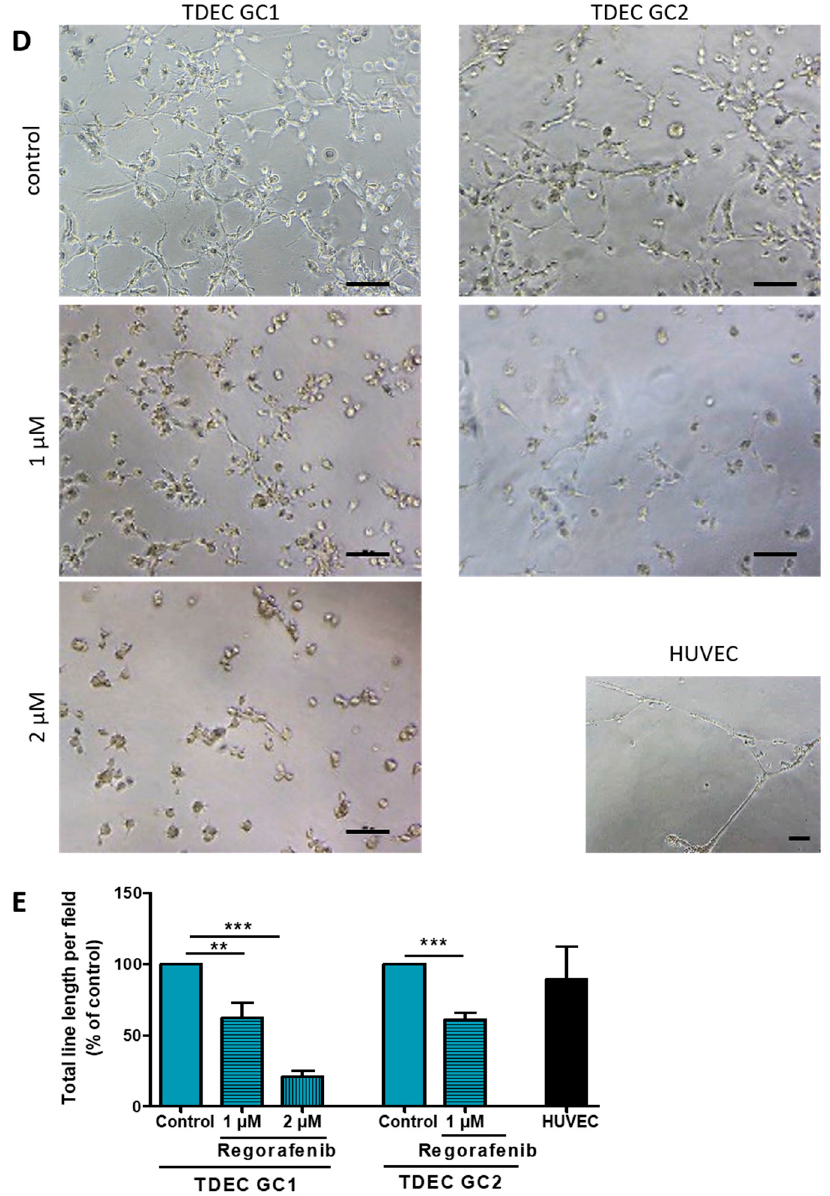
Figure 3. Regorafenib inhibits GSC transdifferentiation into TDEC in vitro. ( A ) GSC isolated from 2 patients (GC1 and GC2) were cultured in EGM-2 for 15 days in order to obtain TDEC (TDEC GC1 and TDEC GC2). ( B ) Immunoblot of CD31 in TDEC GC1 and TDEC GC2 with or without 1 or 2 µM of regorafenib. The graph shows the protein expression ratio normalised to TDEC obtained from each GSC and not treated with regorafenib (control). ( C ) Flow cytometric analysis of CD31 expression in TDEC obtained from GC1 and GC2 with or without regorafenib. The level of CD31 positive cells is expressed as the mean ± SEM normalised to TDEC obtained from each GSC and not treated with regorafenib (control). HUVEC is shown here as a positive control of CD31 expression. ( D , E ) Pseudotube formation assay. ( D ) Representative photographs of pseudotubes formed by TDEC GC1or TDEC GC2 treated or not with regorafenib. HUVEC is shown here as a positive control of pseudotube formation. Scale bars, 100 µm. ( E ) The graph shows the mean ± SEM of the total line length per field determined by quantification of at least 3 fields per well, normalised to TDEC obtained from each GSC and not treated with regorafenib (control). HUVEC is shown here as a positive control of pseudotube formation; * p < 0.05; ** p < 0.01; *** p < 0.001.